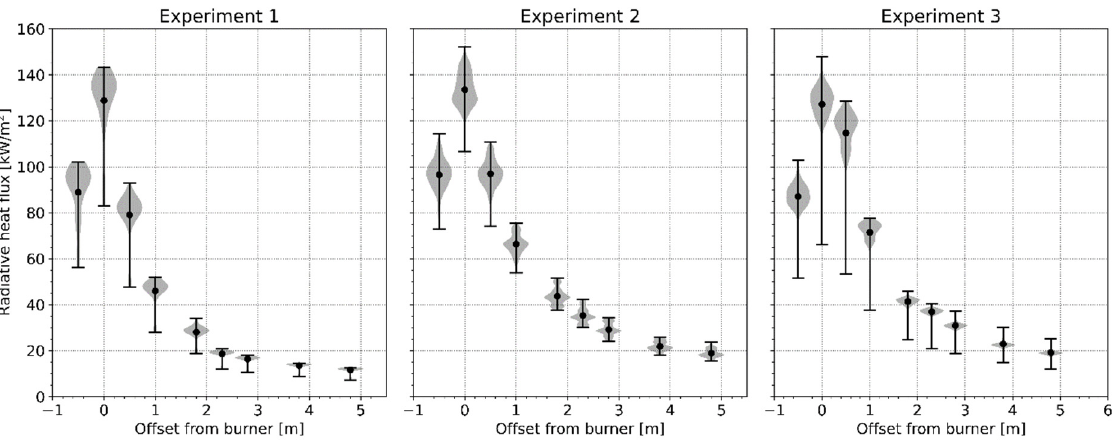
Figure 21. Violin plot of radiative heat flux to the ceiling for all experiments at different offsets from the burner array, indicating range, probability distribution and mean values, whilst burner array HRR = 1250 kW.